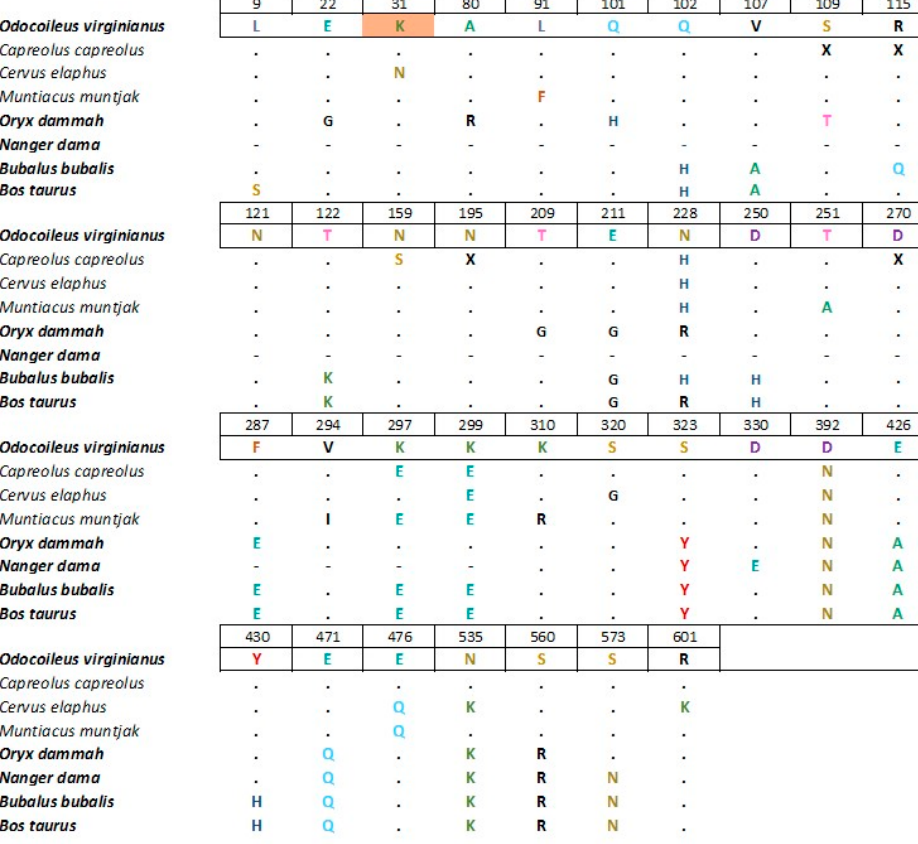
Figure 2. Multiple sequences the ACE2 protein were performed with the species characterized in [7], and additional deer species included from GenBank (GCA_000751575.1, XP_037678579.1, XP_012949915.3, QEQ50331.1, KAB0345583.1, XP_043752042.1, XP_036696353.1). The full alignment is in Supplementary Figure S1. The figure only shows deer and related bovids and only positions where there are amino acid changes relative to white-tailed deer ( Odocoileus virginianus ). Alignments were performed using ClustalW Multiple Alignment in BioEdit version 7.2.5. The names of species highlighted in bold correspond to species known to be susceptible to SARS-CoV-2 and the amino acid position highlighted in orange is a hot spot for SARS-CoV-2 S-binding [7]. Ambiguities in database sequences are designated as X. Dots represent identity to the reference and dashes represent missing sequence information.